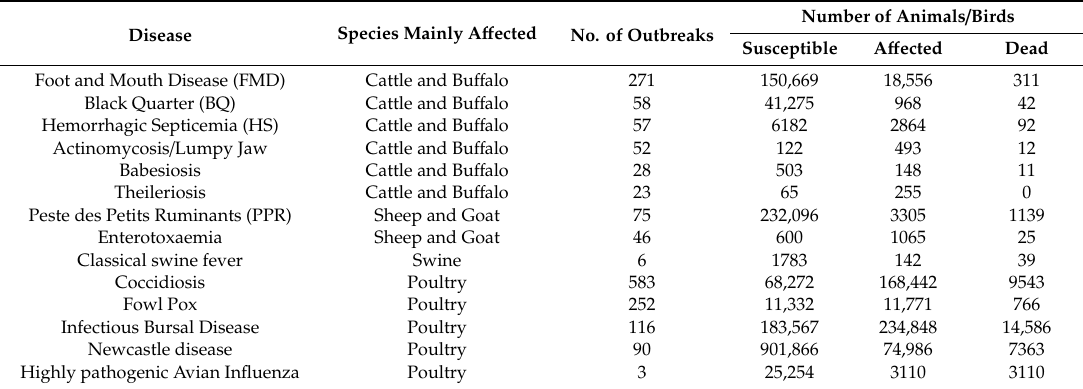
Table 3. Status of the World Organization of Animal Health (OIE)-listed major disease outbreaks of livestock and poultry in the year 2018 (January–December)